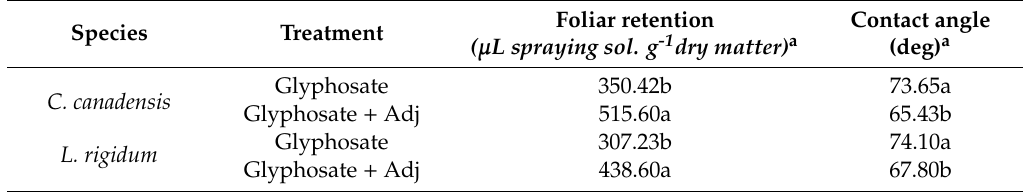
Table 2. Spray retention and contact angle of glyphosate solution for C. canadensis and L. rigidum populations.